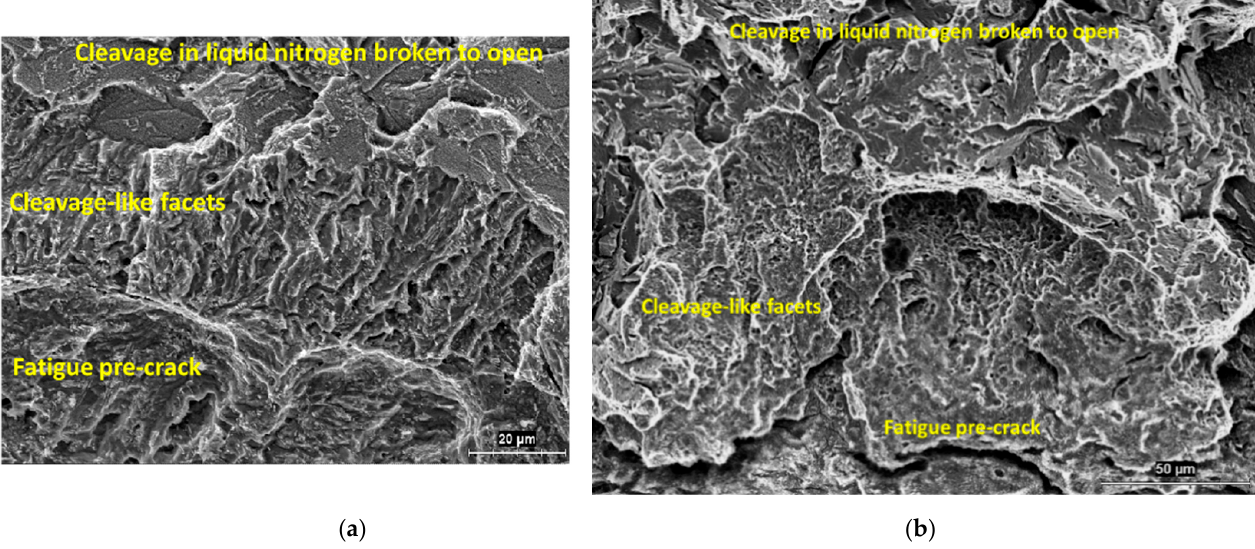
Figure 2. Typical cleavage-like facets of EAC initiated in low-alloy steels (LAS) growing from fa-tigue pre-crack tip while tested by constant load: ( a ) 22NiMoCr3-7 exposed to simulated boiling water reactor (BWR) conditions at 288 ◦ C for 1904 h at stress intensity of 49 MPam1/2; ( b ) CrNiMoV exposed to simulated VVER water saturated with oxygen (>1 ppm) at 320 ◦ C for 1023 h at 36 MPam 1/2 . The fracture surfaces were chemically cleaned to remove